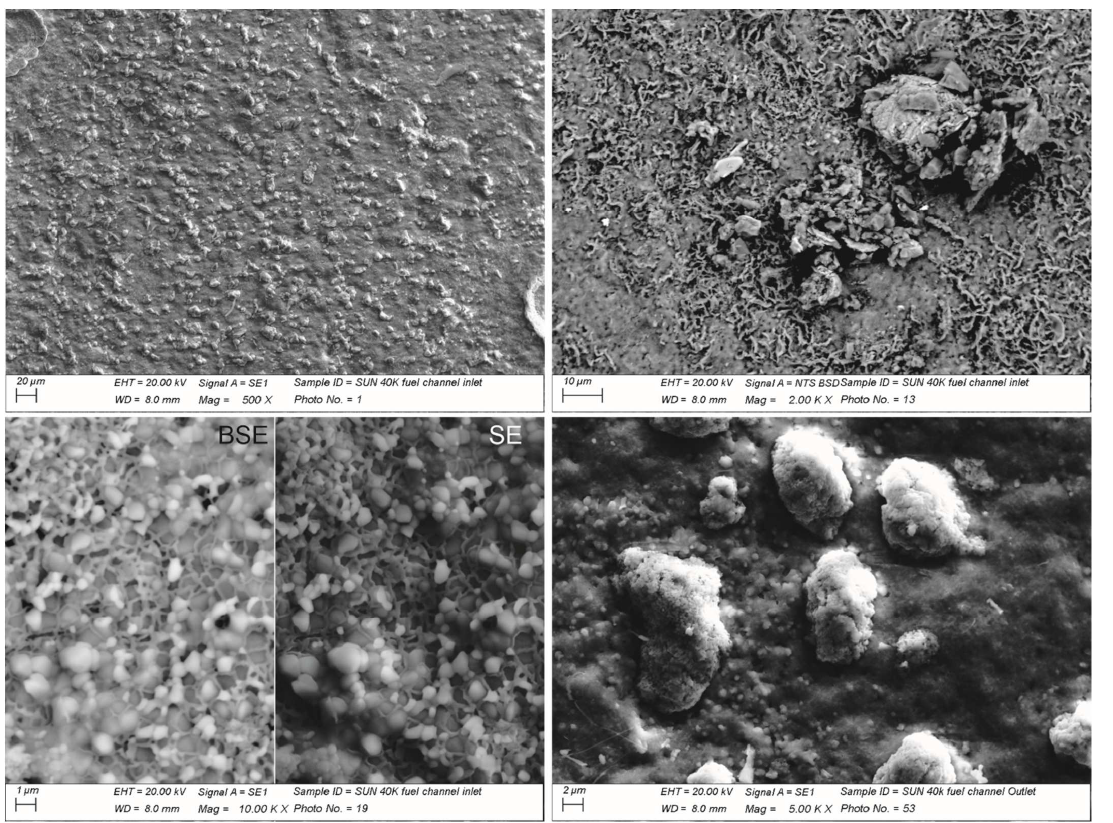
Figure 7. SEM pictures with details of the various oxide features found on top of the fuel side. In a cross-section (Figure 8), the TGO appeared well adhered to the metal substrate without gaps or cracks. It penetrated the pores and other pre-existing defects. A tiny and diffused porosity appeared in the TGO. Such small pores grew and tended to concentrate halfway between the metal substrate and the external edge in the second half of the MIC (Figure 9a).